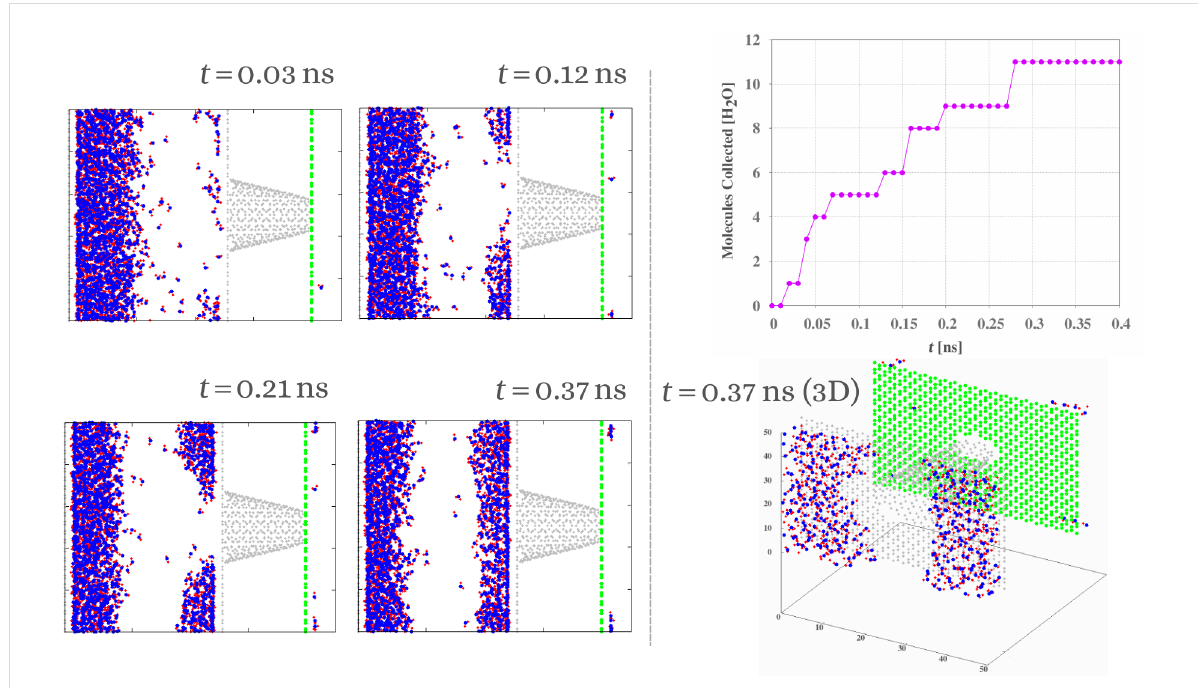
Figure 6: 2D snapshots of the temporal evolution for vapor for a hydrophobic nanocone (left), the number of collected water molecules as a function of the time (top right), and a 3D snapshot for t = 0.37 ns (bottom right).